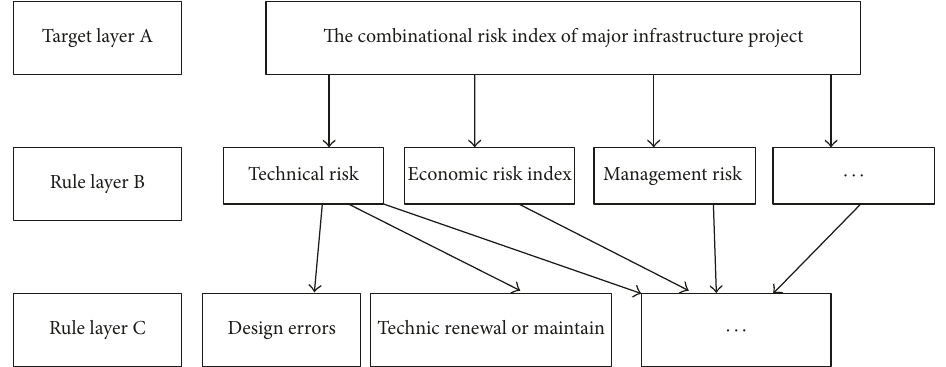
Figure 1: The hierarchy of project risk index.